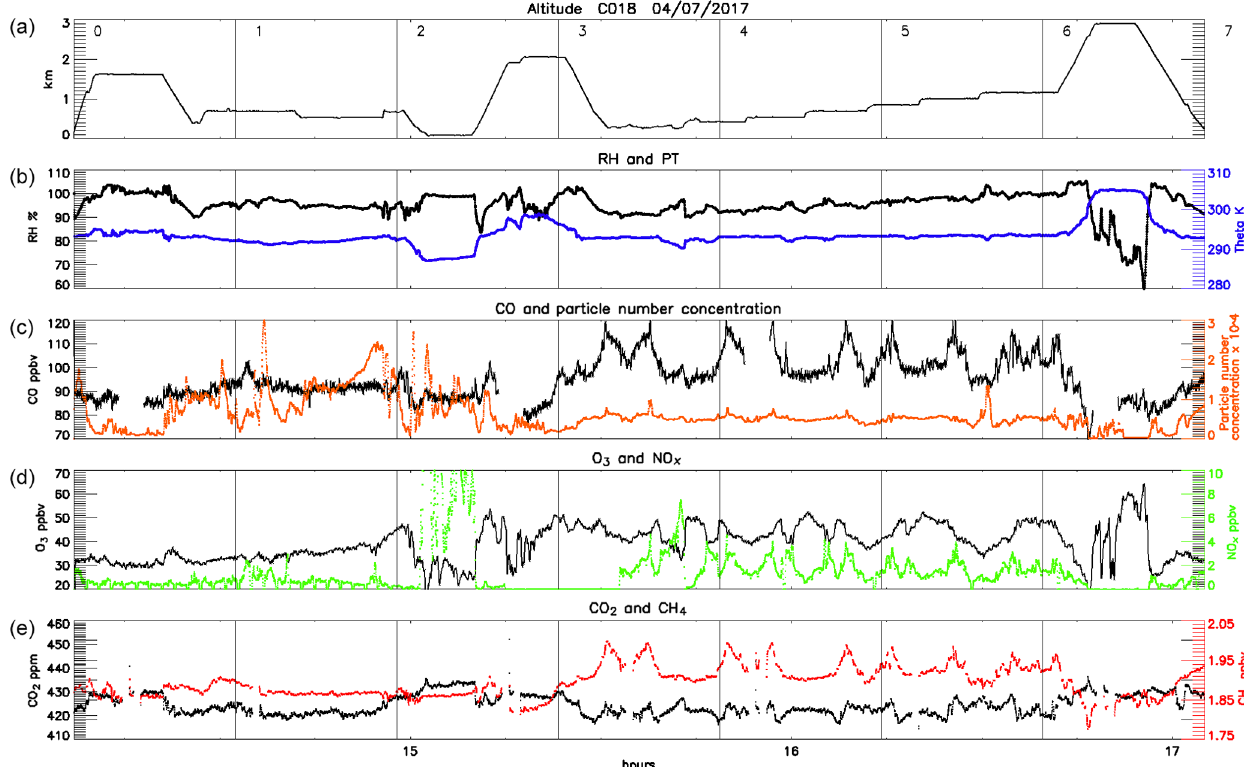
Figure 6. As in Fig. 4 but for the third flight (C018; 4 July,